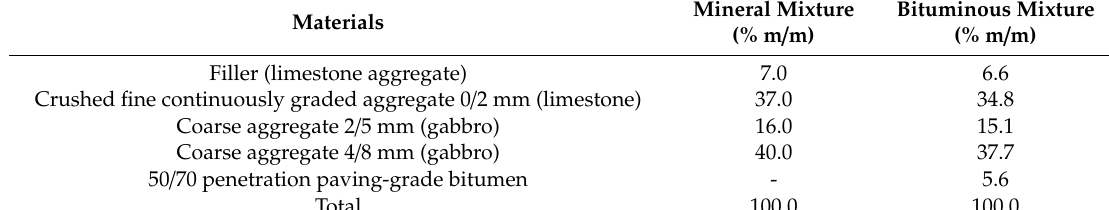
Table 4. Composition of AC 8 mineral mixture [72].